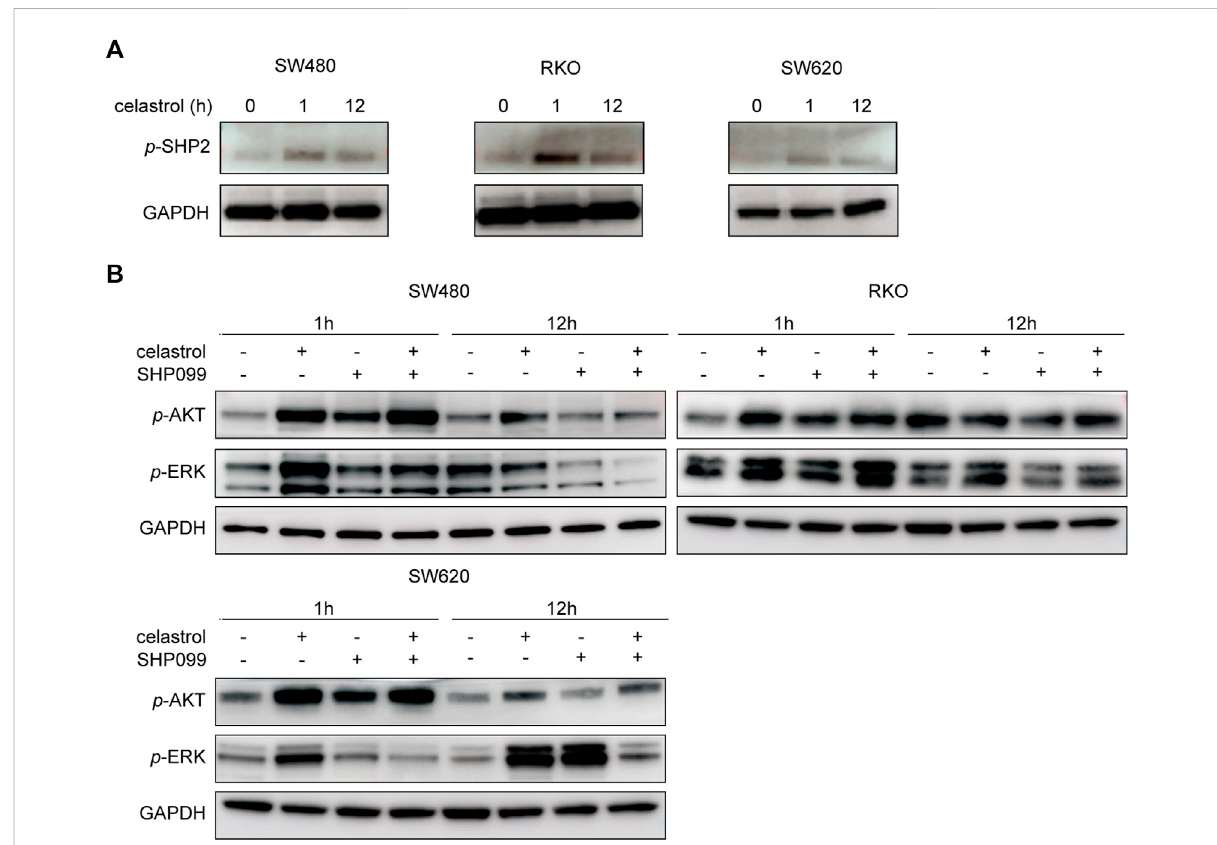
FIGURE 3 Inhibition of SHP2 blocked RTK-related AKT/ERK activation by low-dose celastrol. (A) Expression of p -SHP2 in CRC cells treated with 0.25 μ M celastrol for 0, 1, and 12 h. (B) Expression of p -AKT and p -ERK in CRC cells treated with celastrol alone, SHP099 alone, or their combination for 1 and 12